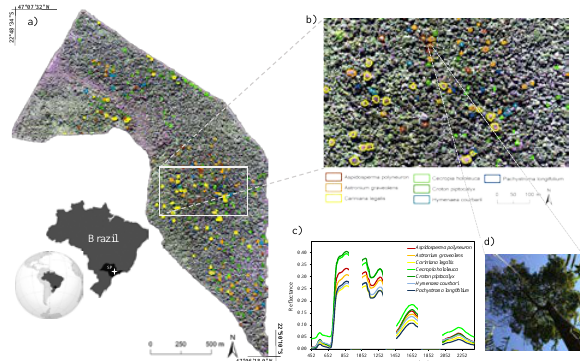
Figure 1. (a) Location of the study area in Brazil, detailing the St. Genebra Forest Reserve with a true color composite (R=639 nm; G=548 nm; B=460 nm) yielded from hyperspectral data; (b) Tree crowns manually delineated and identified to the species Figure 2. Spectral filter functions of WorldView-3 level in the field; (c) Mean spectral response of the approached species; (d) Photograph taken on 28/May/2014 of the crown of Aspidosperma polyneuron .